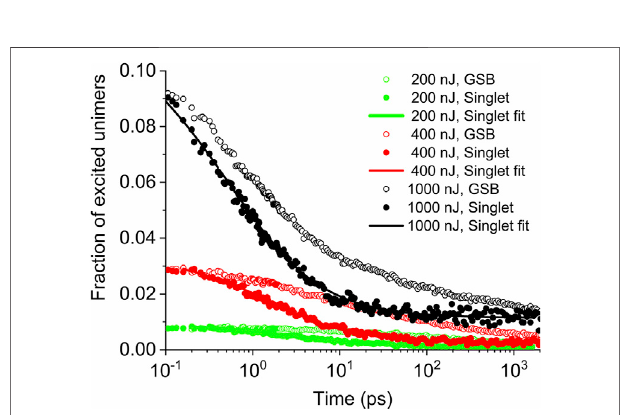
FIGURE2| Timeevolutionofthesingletexcitonpopulation(fullsymbols) and of the ground-state bleach (open symbols) for different pump fl uences indicated in the legend. Solid lines represent the best fi ts according to Eq. 2